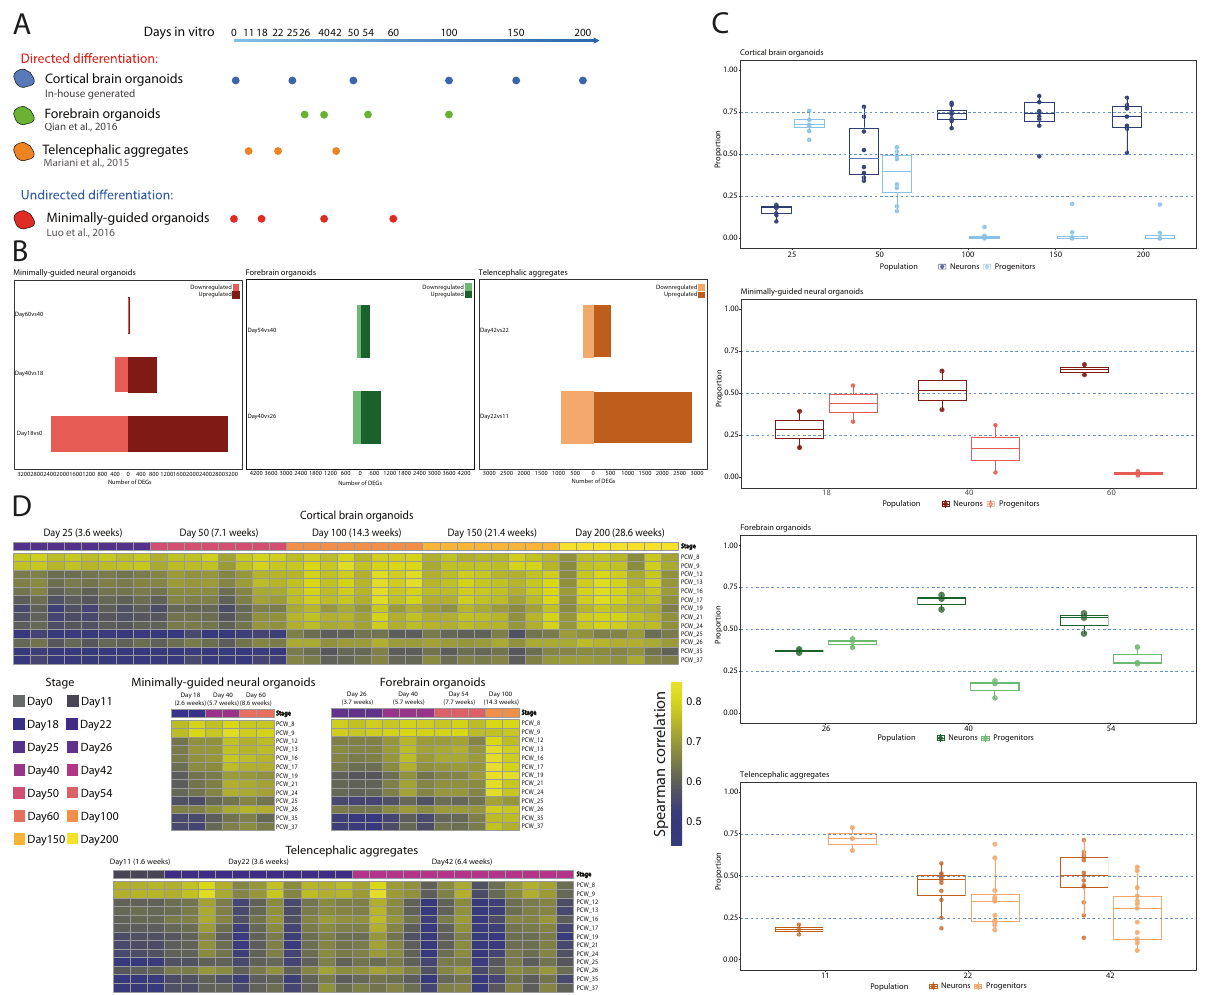
Fig. 4 Brain organoids differentially recapitulated the timing of corticogenesis. A Schematic representation of in-house and external BO datasets and relative differentiation time points (CBO cortical brain organoids, FO forebrain organoids, TA telencephalic aggregates, MGO minimally-guided neural organoids). B Stage-wise differential expression analysis in MGO, FO, and TA. Barplots reporting the number of DEGs (FDR < 0.05, log2FC > 1 as absolute value), shown as upregulated and downregulated genes for each comparison. C Boxplots reporting the fraction of Progenitors and Neurons estimated by bulk deconvolution in each organoid dataset. D Correlation analysis of organoid datasets against the BS fetal cortex. Heatmaps visualize the correlation coef fi cient (Spearman correlation) for each organoid data point and each BS other models compared to CBO, given the time points for which the overlap was signi fi cant. Bulk deconvolution analysis focusing on two broad cell populations (early progenitors and neurons) showed progenitors as predominant in all models at early stages (Fig. 4C). In CBO, proportions of the two populations were comparable at day 50, with neurons prevalent from day 100 onwards. MGO, FO, and TA showed a similar but accelerated dynamic compared to CBO, again indicating a more rapid transcriptional maturation. We then tested the transcriptional similarity of each model towards BS fetal cortex (Fig. 4D). Whole-transcriptome correlation showed for CBO a gradual increase of similarity towards mid and late PCW over time. We observed a more time-compressed evolution among MGO and FO, which already by day 60 showed an extent of similarity with late PCW that CBO reached only by day 100. For CBO and TA, the dataset encompassed organoids generated from different control individuals. CBO demonstrated robust reproducibility across genetic backgrounds and batches of differentiation, while TA were less tolerant to interindividual variability. These observations were further con fi rmed by using CBO as reference (Supplementary Fig. 8D).